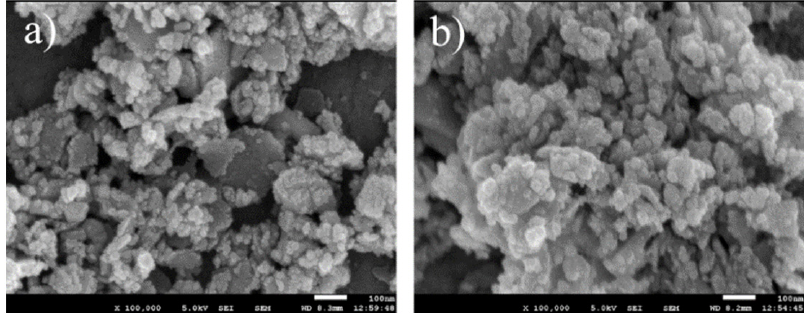
Figure 2. SEM images of catalysts: ( a ) CZAGa-0; ( b ) CZAGa-2.